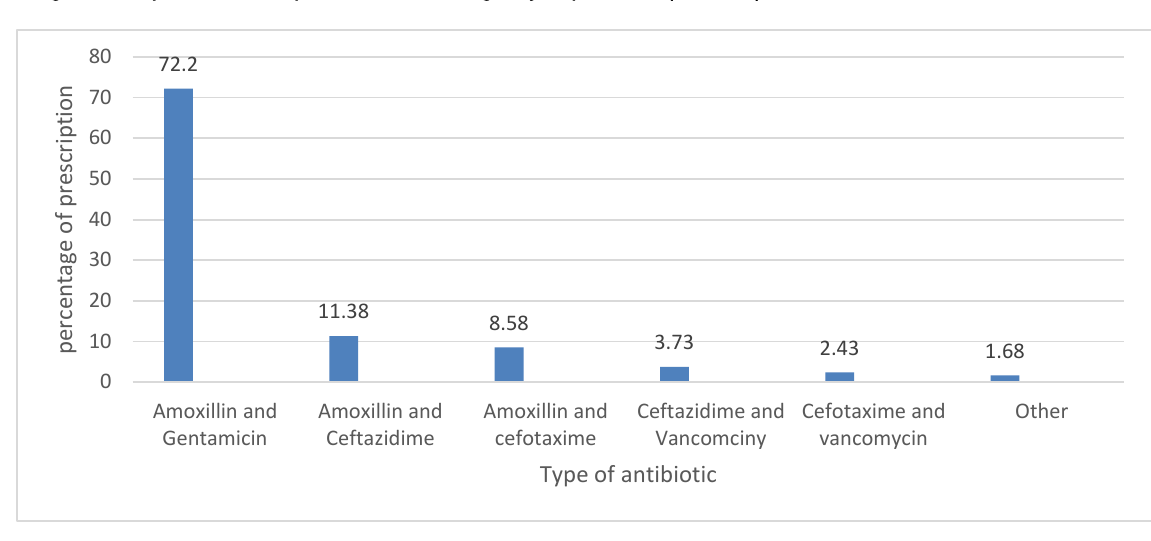
Figure 7: Triple antibiotics prescribed in emergency department (Total 28).